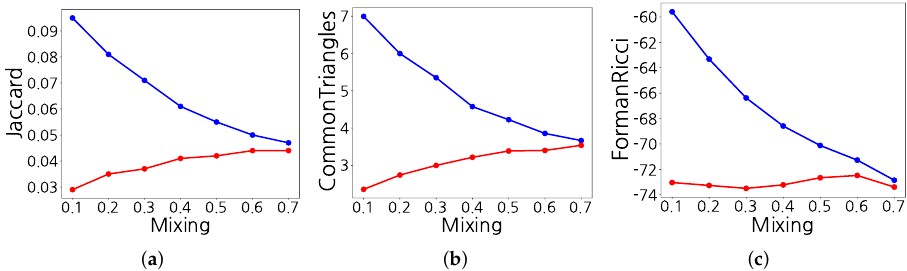
Figure 1. Distribution of link attributes in synthetic networks: ( a ) Jaccard; ( b ) CommonTriangles; and ( c )